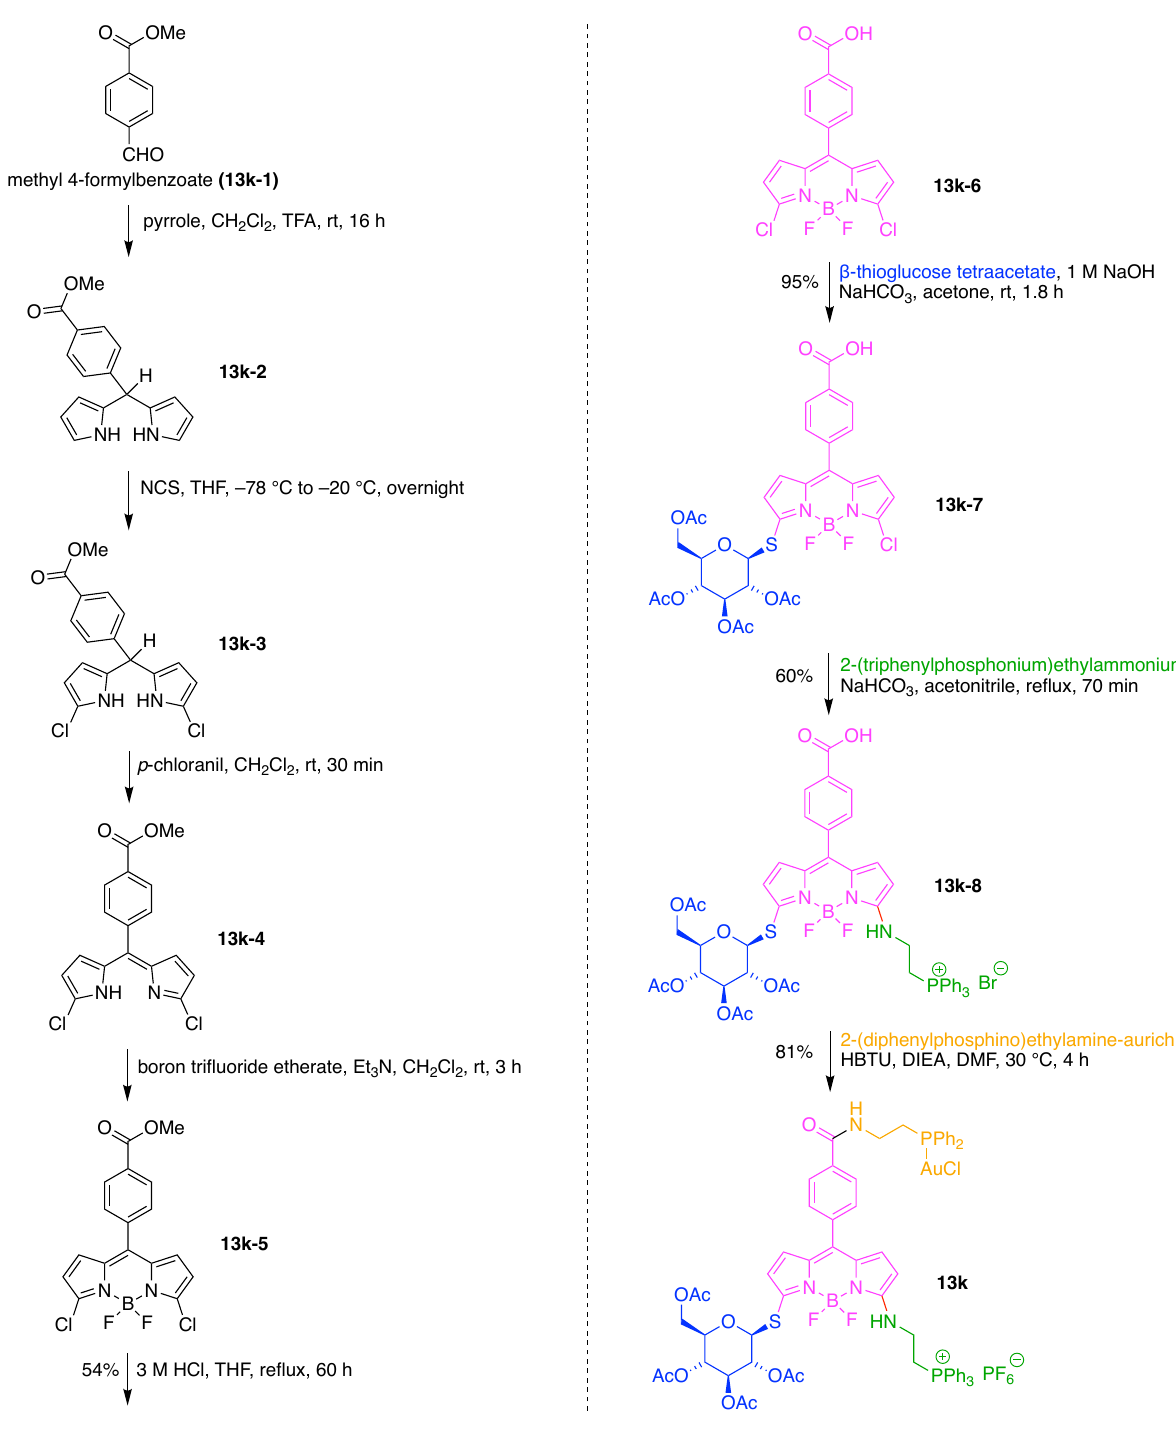
Figure 71. Synthesis of a tri-functionalized BODIPY.